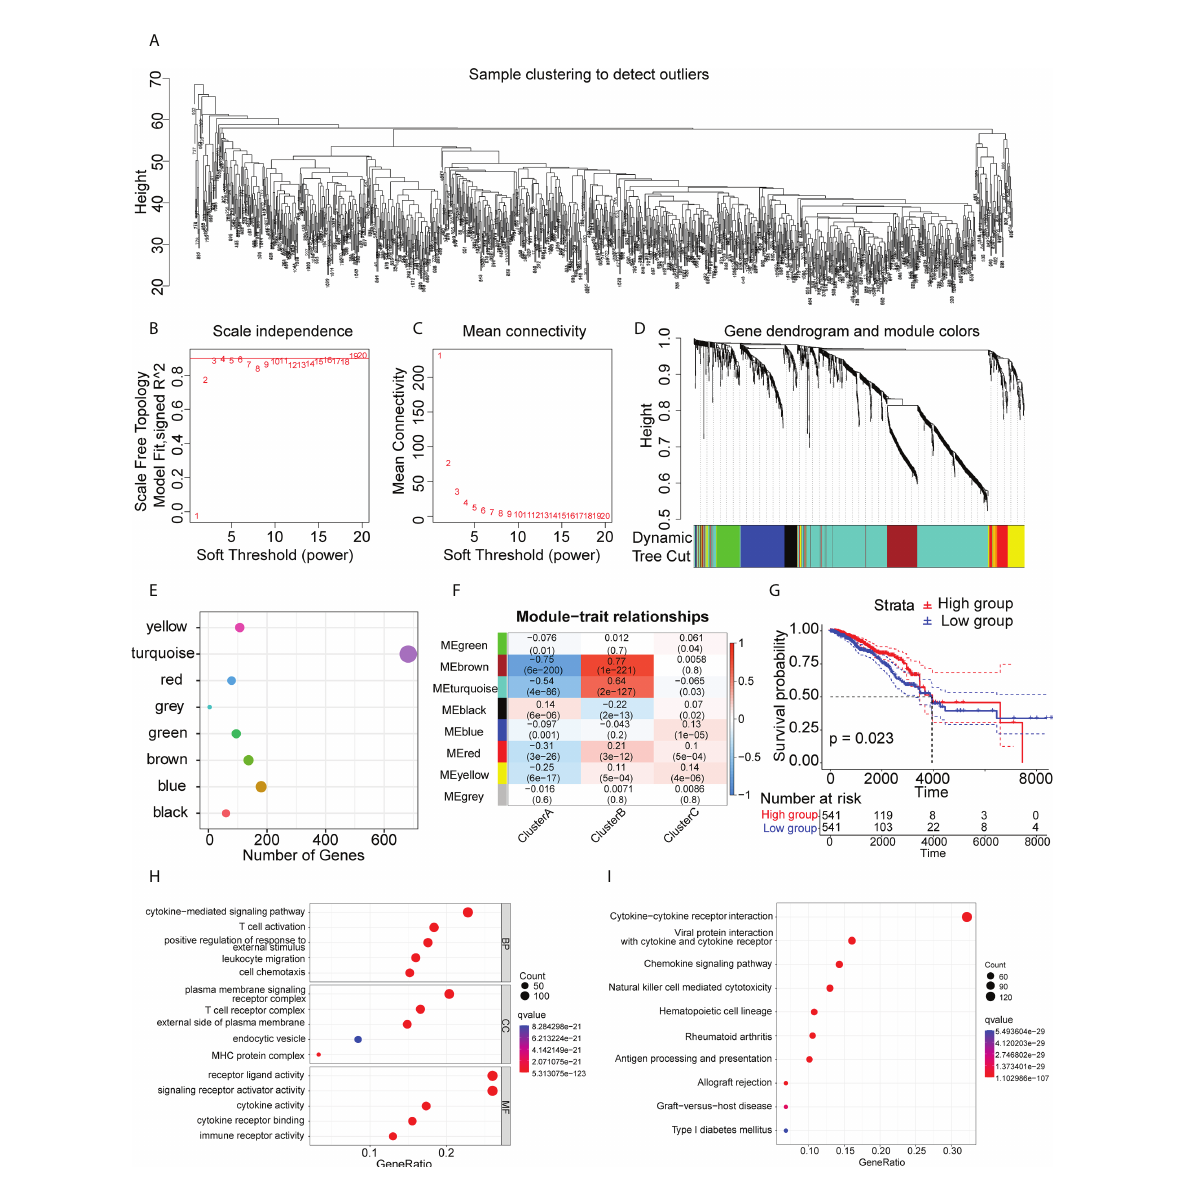
FIGURE 7 Immune gene co-expression modules. (A-D) Co-expression network of immune-associated genes. (E) Dot plot of co-expression modules. (F) Correlations between modules and immune clusters. (G) Survival analysis of patients with high and low scores for genes in the “ turquoise ” module. (H) GO analysis of genes in the “ turquoise ” module. (I) KEGG analysis of genes in the “ turquoise ”